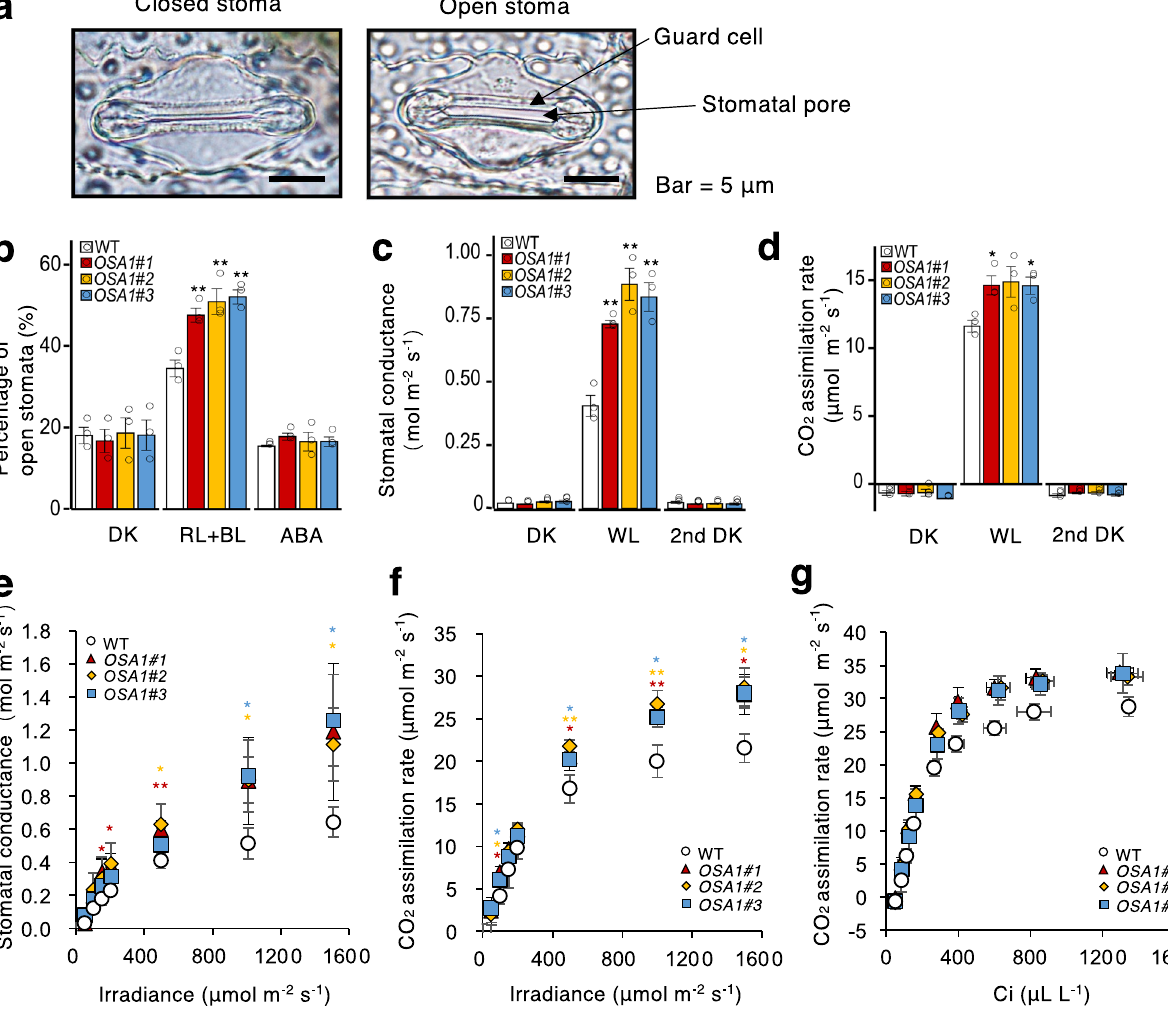
Fig. 4 Stomatal and photosynthetic properties of OSA1 -ox plants. a Representative stomata in the epidermis of WT plants. Experiments were repeated three occasions with similar results. b Percentage of open stomata observed after 3 h of darkness (DK), red light plus blue light (RL + BL) or RL + BL in the presence of 20 μΜ abscisic acid (ABA) in WT and OSA1 -ox plants (for the details see the “ Methods ” section). c , d Stomatal conductance ( c ) and CO 2 assimilation rate under ( d ) DK (30 min), white light (WL; 2 h) and a second DK treatment (30 min) in WT and OSA1 -ox plants. e , f Stomatal conductance ( e ) and CO 2 assimilation rate ( f ) in response to light in WT and OSA1 -ox plants. g Relationship between CO 2 assimilation rate and intercellular CO 2 concentration in WT and OSA1 -ox plants. Small circles in b – d represent data points for individual experiments; three biological replicates were analysed for each treatment. Values in b – d are presented as the means ± SEs ( n = 3) and those in e – g are the means ± SDs ( n = 3). Differences were evaluated using the two-tailed Student ’ s t test (* P < 0.05; ** P < 0.01). The exact P values are provided in the Source Data fi